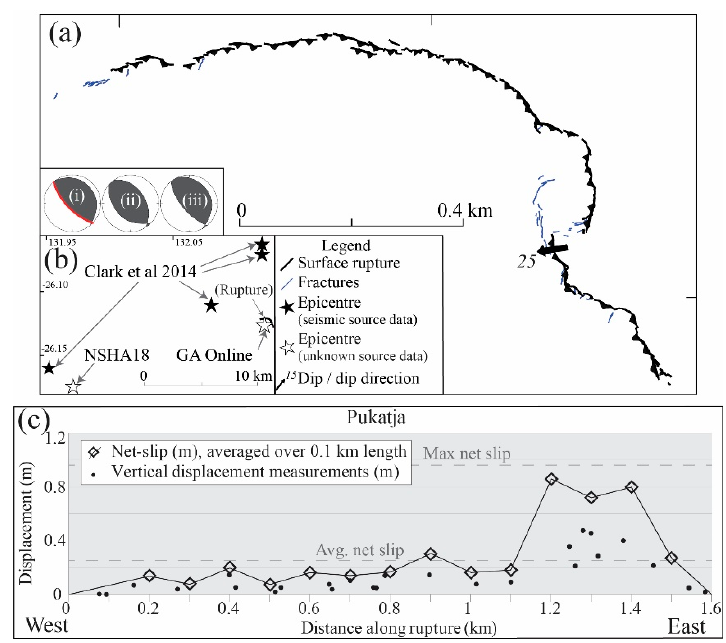
Figure 9. 2012 Mw 5.2 Pukatja / Ernabella earthquake ( a ) rupture and fracture map of Pukatja scarp and available dip measurements also the location of hand-dug trench [9], focal mechanisms as described in [9] from (i) Clark et al. 2014, (ii) GCMT, (iii) St Louis University; ( b ) graph of along-rupture vertical displacement measurements [9] and net slip calculated from available data averaged over 0.1 km increments (this study).